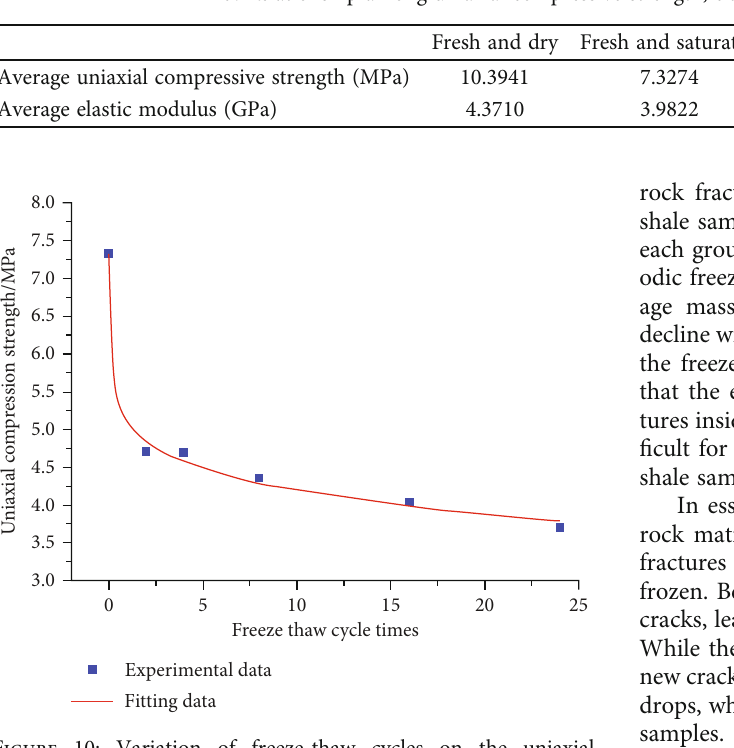
Table 5: Relationship among uniaxial compressive strength, elastic modulus, and freeze-thaw cycles.